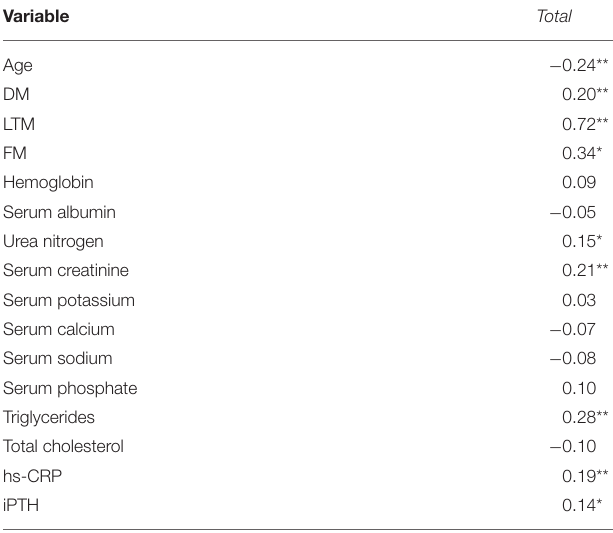
TABLE 3 | Correlation Coefficients between variables and REE.